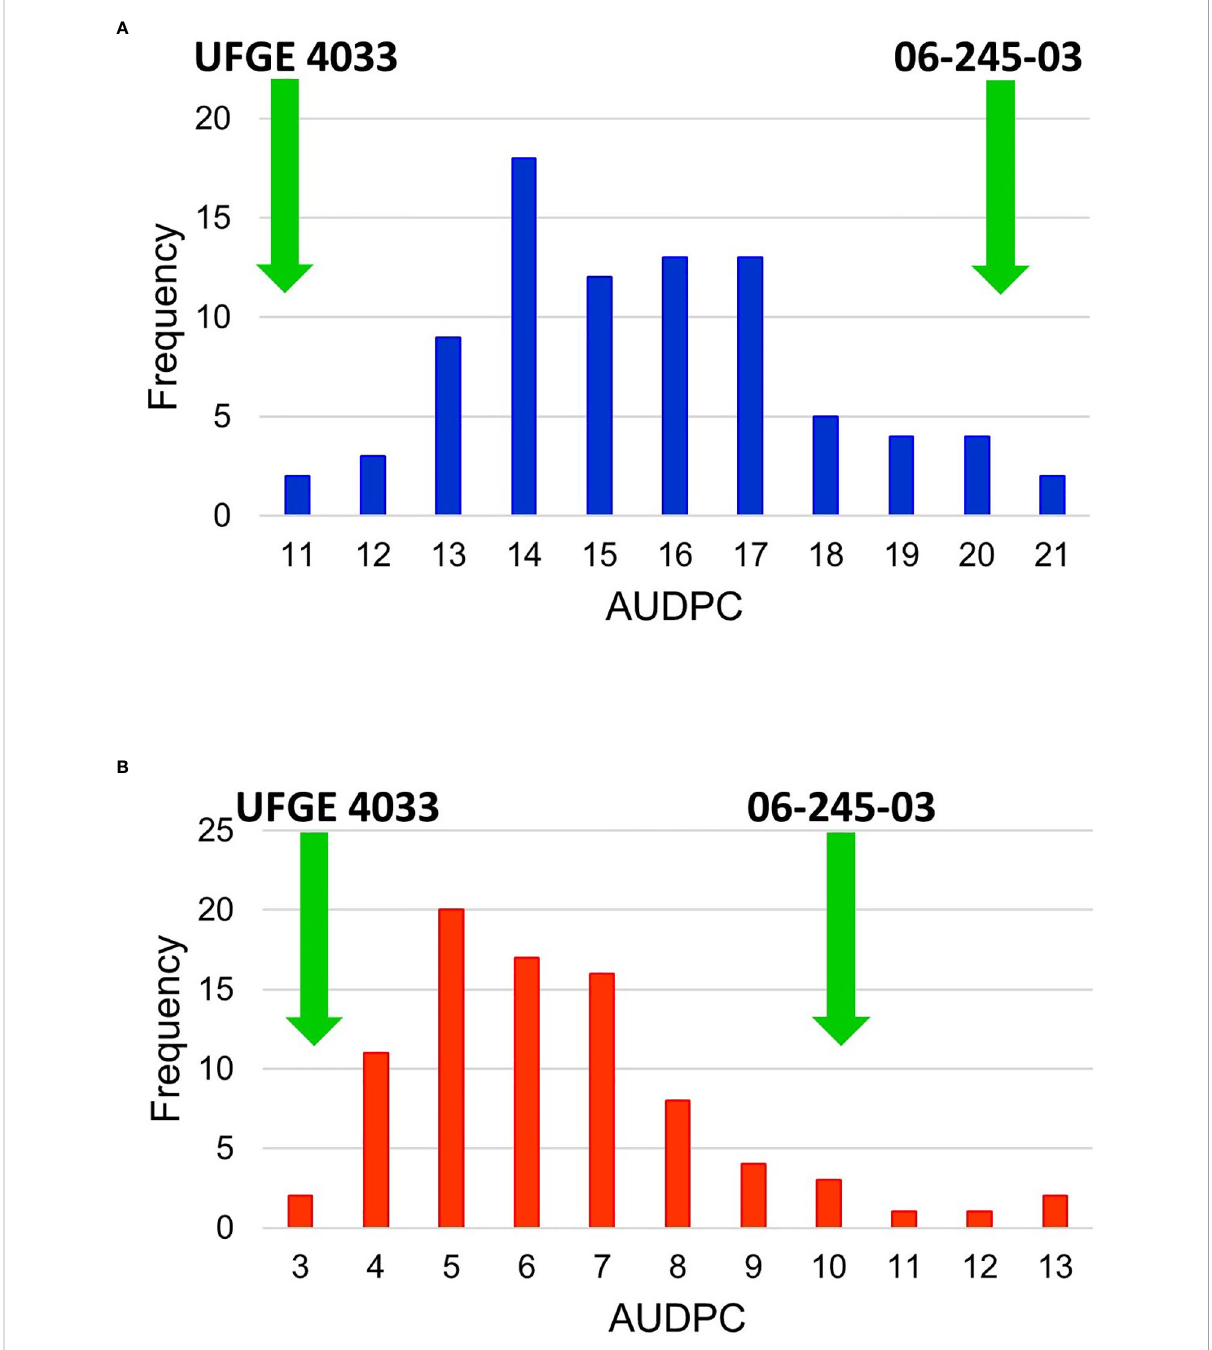
FIGURE 3 Frequency histogram of the Area Under Disease Progress Curve (AUDPC) values of an F 1 segregating population in (A) year 2018 and (B) 2019 for powdery mildew. The segregating population was developed by crossing Gerbera breeding lines 06-245-03 and UFGE 4033. The green arrows indicate the scores of resistant (UFGE 4033) and susceptible (06-245-03) parents used in developing the mapping